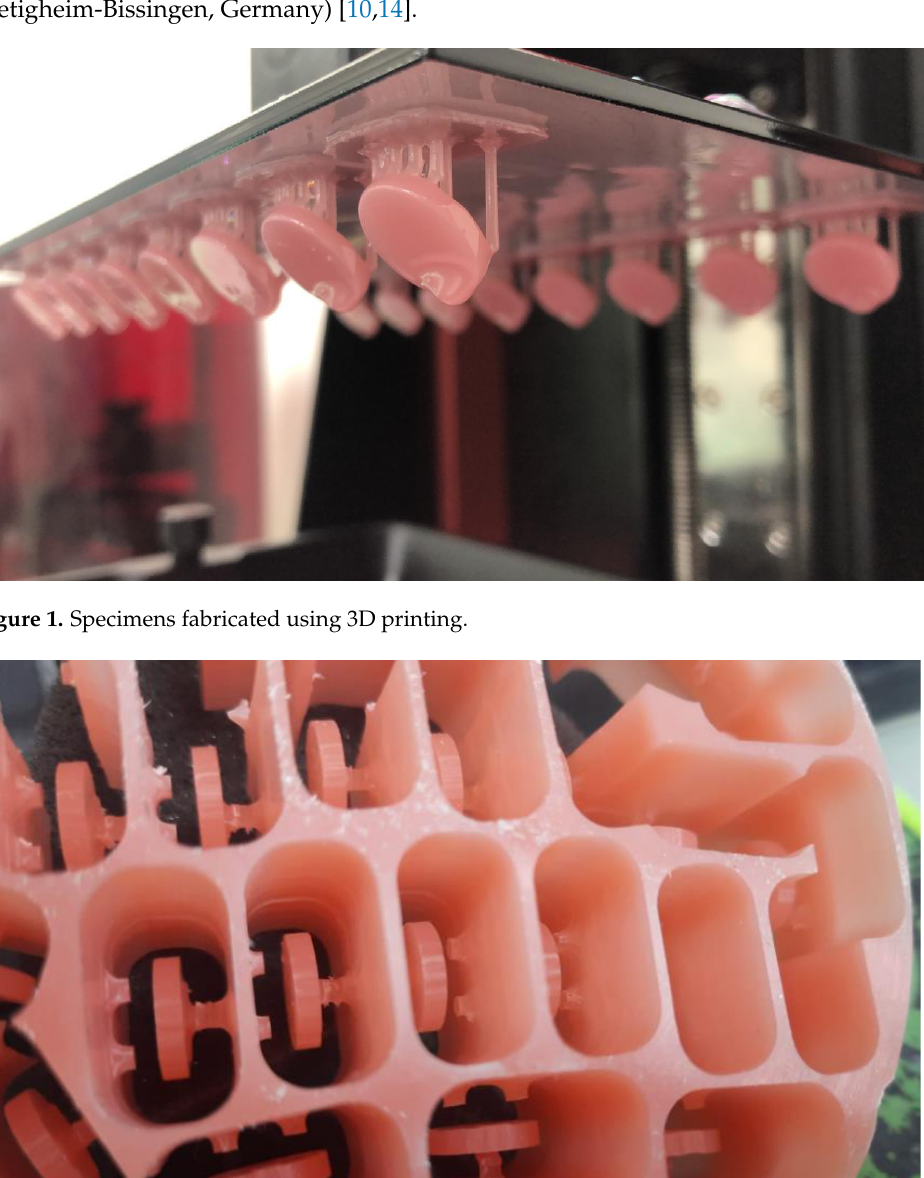
Figure 3. Wax patterns for fabricating specimens using the conventional compression-molding tech- nique. 2.3. Initial Color and Surface-Roughness Testing The samples were randomly divided into three subgroups ( n = 14). They were dried using sterile tissue paper and their initial color (colorimeter, CS-10, Hangzhou Quality Lab Scientific Co. Ltd., Hangzhou, China) and surface roughness (3D optical non-contact surface profiler, UMT1, Campbell, CA, USA) were recorded. The color readings were rec- orded against a white background [34,35]. In total, three readings were recorded from the center of the specimens, and these values were then averaged. The CIELAB color system was used to describe the color coordinates. 2.4. Immersion Protocol In this study, two common smokeless tobacco products were selected: khaini and tabbaq smokeless tobacco (Table 2 and Figure 4). Suspensions of these smokeless tobacco products were obtained with the help of the Substance Abuse and Toxicology Research Center, Jazan University. The solutions were prepared by mixing 20 pouches of smokeless tobacco in 50 mL of distilled water. In each group, three subgroups were created using 14